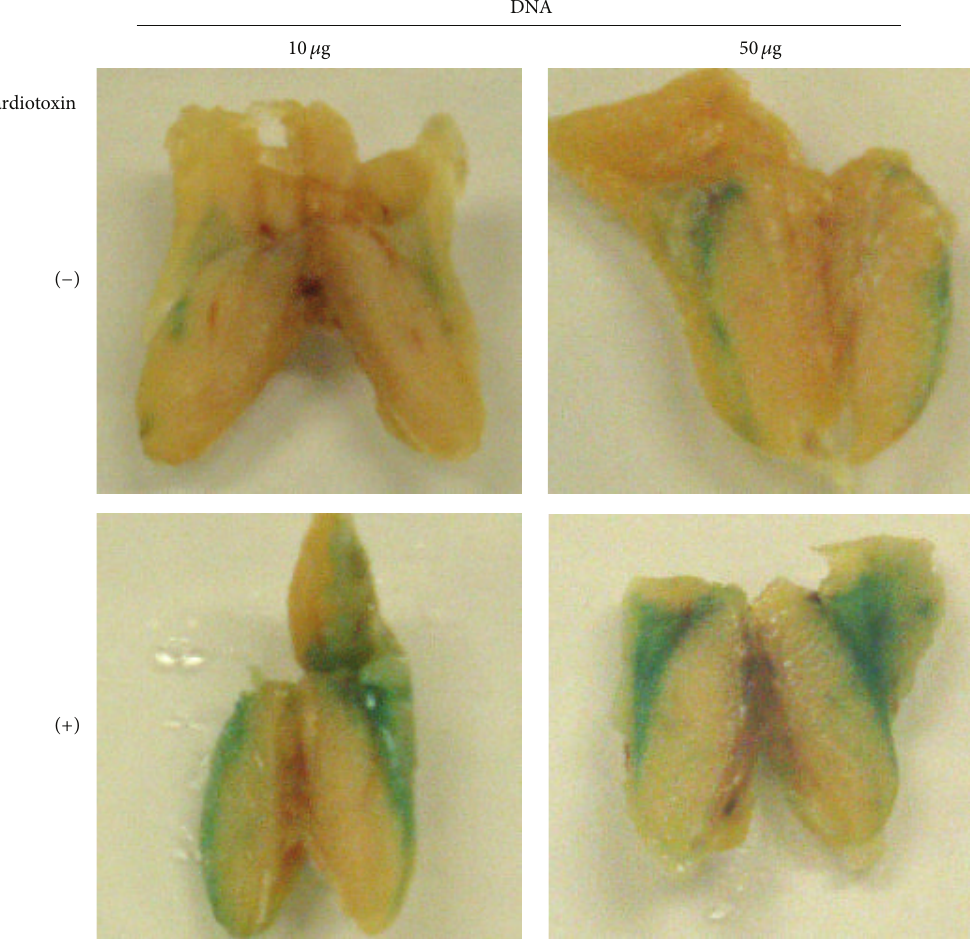
Figure 1: Expression of 𝛽 -gal protein in mice that received DNA immunization. BALB/c mice were injected with or without cardiotoxin at thigh muscles and then with pcDNA3/ 𝛽 -gal (10 or 50 𝜇 g) at the same muscles 5 days later. The thigh muscles were stained with the X-gal staining 5 days after DNA